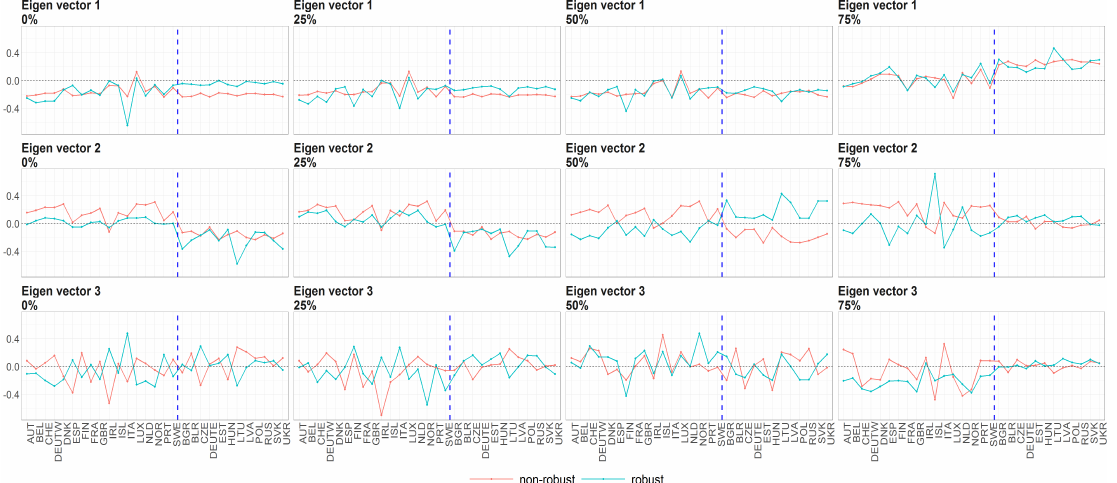
Figure 9. The eigenvectors (y axis) over the joint distribution of countries (x axis) obtained using PPCA for Females in Births. Every row of subfigure corresponds to a different eigenvector. Every column corresponds to different case of missing values (0%, 25%, 50% and 75%). The blue line corresponds to robust standardisation whereas red line to non-robust standardisation of